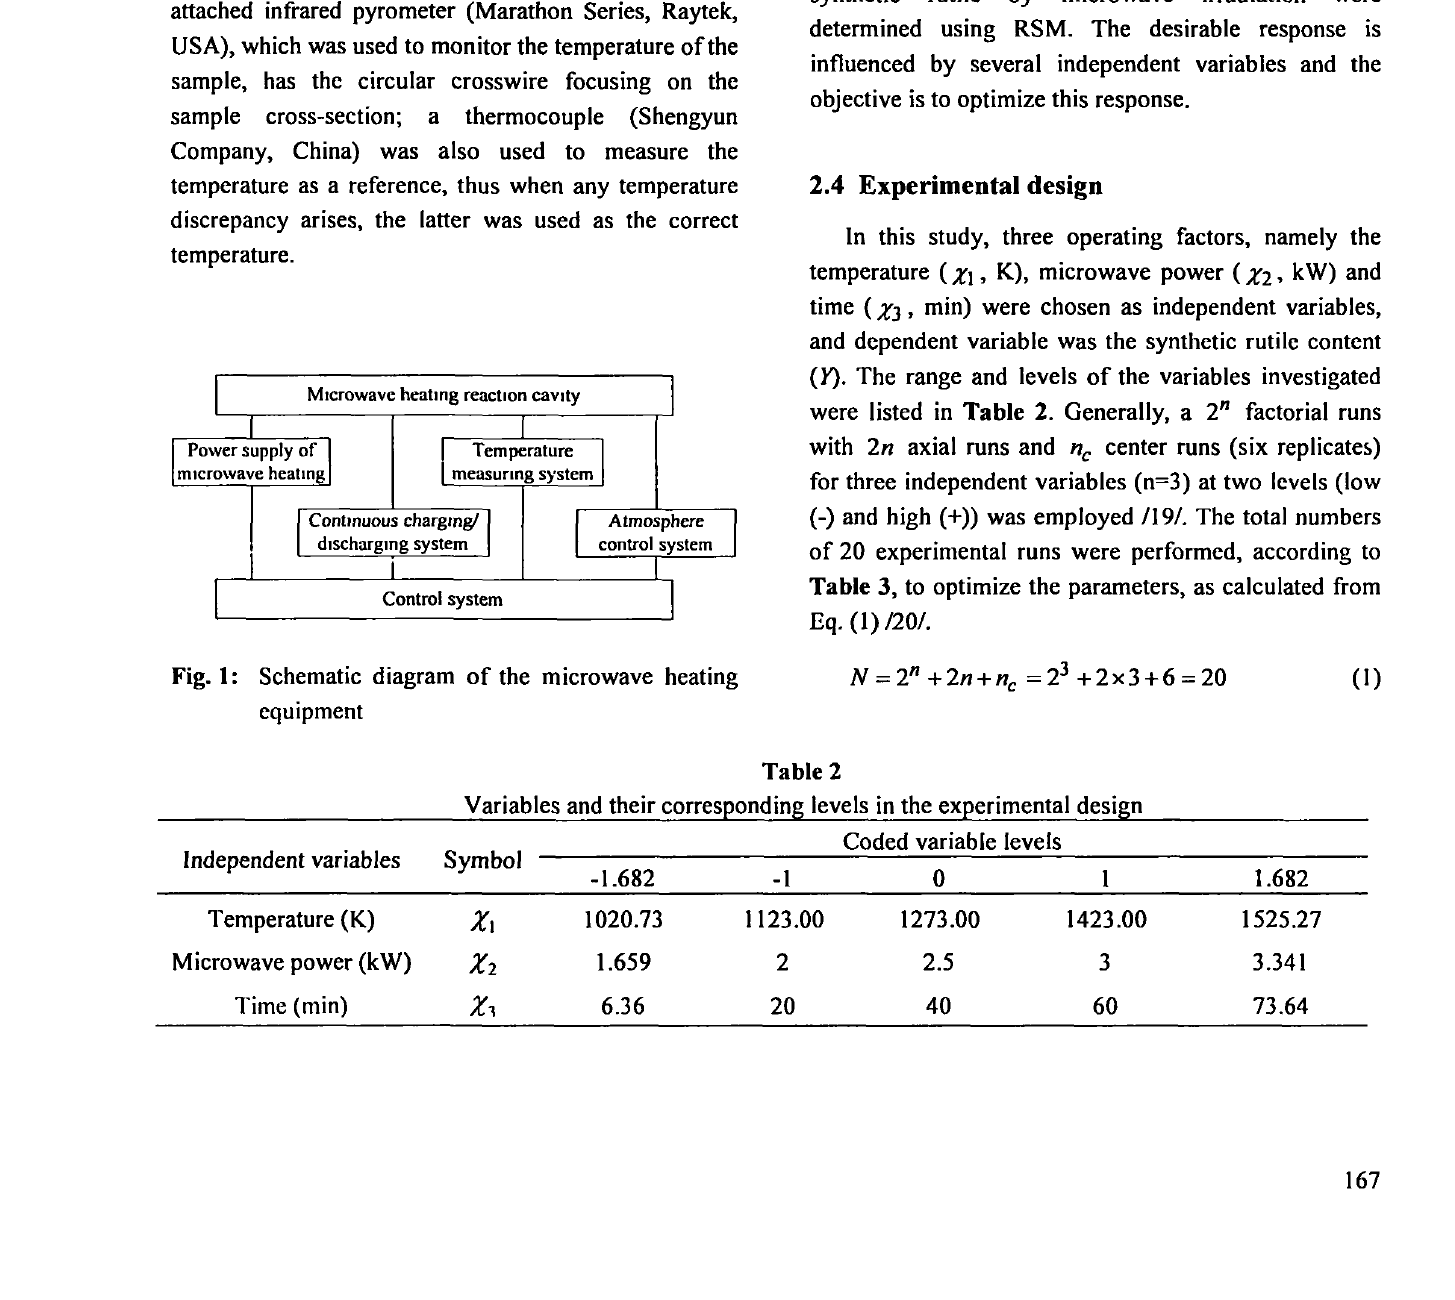
Fig. 1: Schematic diagram of the microwave heating equipment